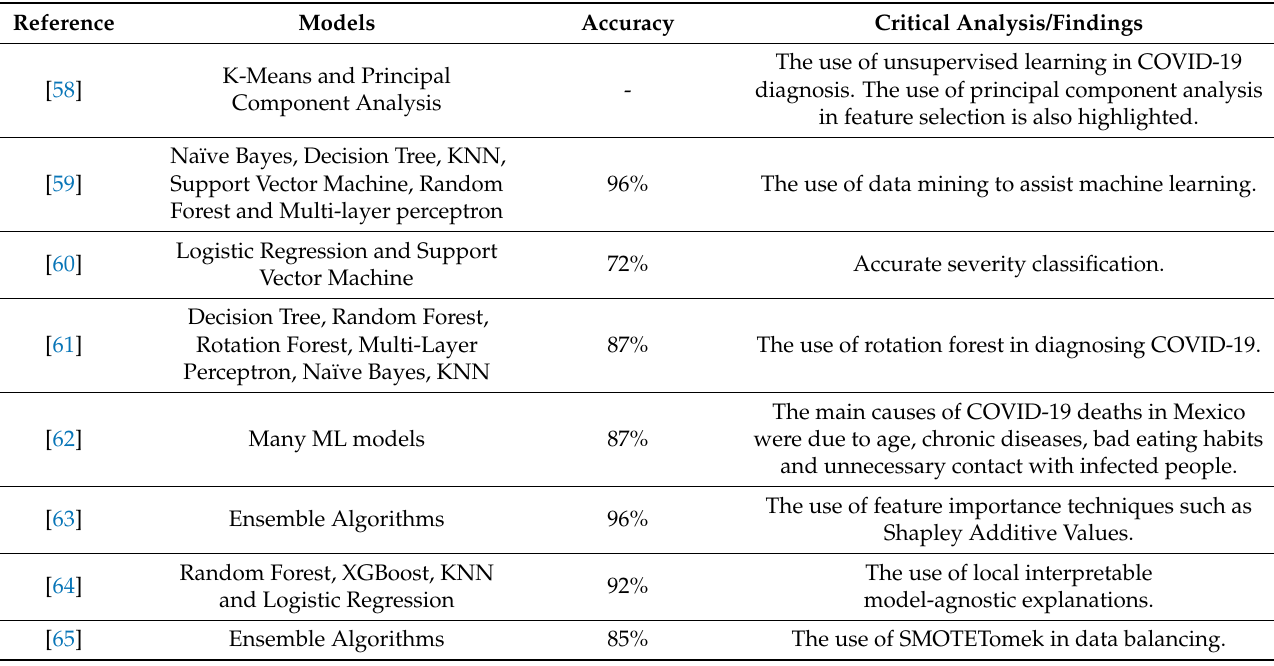
Table 1. Related works which diagnose and predict COVID-19 mortality using machine learning